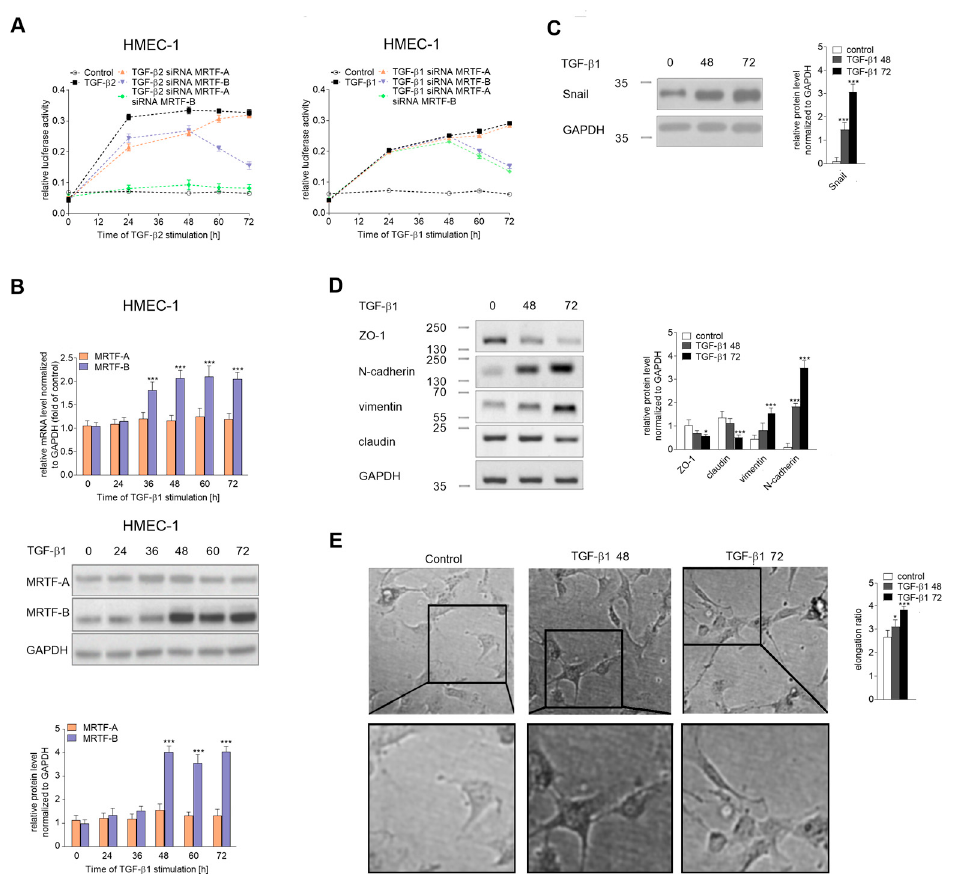
Figure 8. TGF- β 1 induced slow EndMT in HMEC-1 cells. ( A ) HMEC-1 cells were incubated with TGF- β 2 or TGF- β 1 (10 ng / mL) for 24, 48, 60, or 72 h, or alone. Subsequently, the Snail luciferase construct (-997 / 90) was studied in MRTF-A-, MRTF-B-, or MRTF-A–MRTF-B-silenced HMEC-1 cells. Results are given as the standard error of the mean of the relative luciferase activity ( N = 3). ( B ) Cells were incubated with TGF- β 1 (10 ng / mL) for the indicated time points. Then, the expressions of the MRTFs were analyzed by real-time PCR and the protein level was determined by a Western blot analysis of the total lysate. Cells were incubated with TGF- β 1 (10 ng / mL) for 48, 72 h, or alone. Subsequently, ( C ) the level of Snail and ( D ) the levels of EndMT markers were evaluated using Western blot assays with the appropriate antibodies. For the protein level analysis, the background was subtracted and the area for each protein peak was determined. Protein levels were normalized to GAPDH. ( E ) Cell